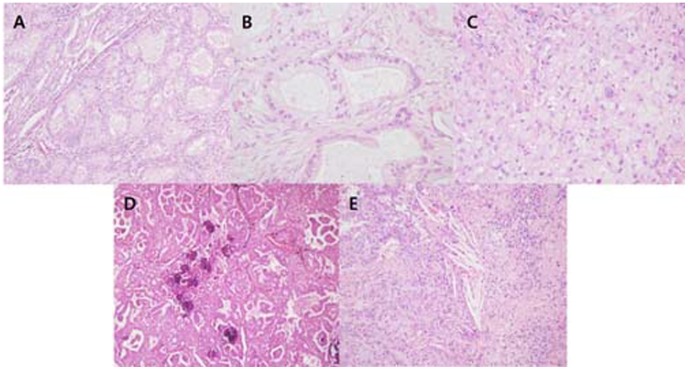
Histological characteristics of ALK-rearranged tumors.A, cribriform formation; B, mucin-containing goblet cells; C, mucin-containing signet-ring cell; D, psammoma body; E, cholesterol cleft.